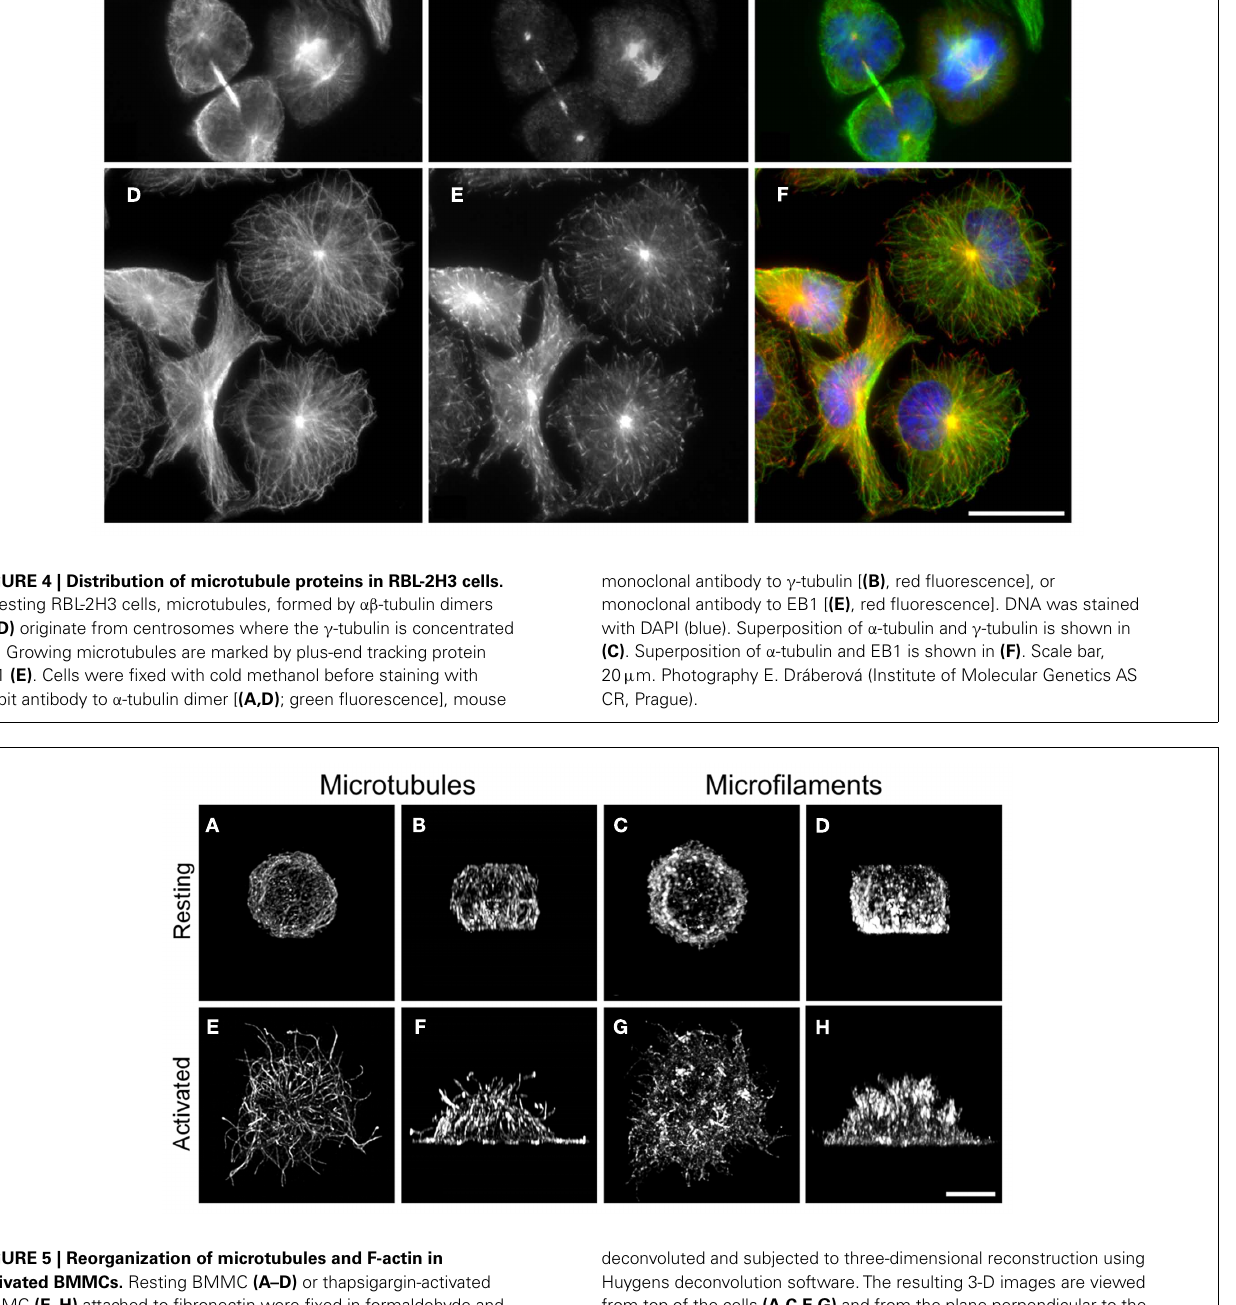
FIGURE 5 | Reorganization of microtubules and F-actin in activated BMMCs. Resting BMMC (A–D) or thapsigargin-activated BMMC (E–H) attached to fibronectin were fixed in formaldehyde and extracted inTriton X-100. Cells were double label stained for α -tubulin (A,B,E,F) and F-actin (C,D,G,H) , and examined with laser scanning confocal microscope.The stacks of confocal sections were